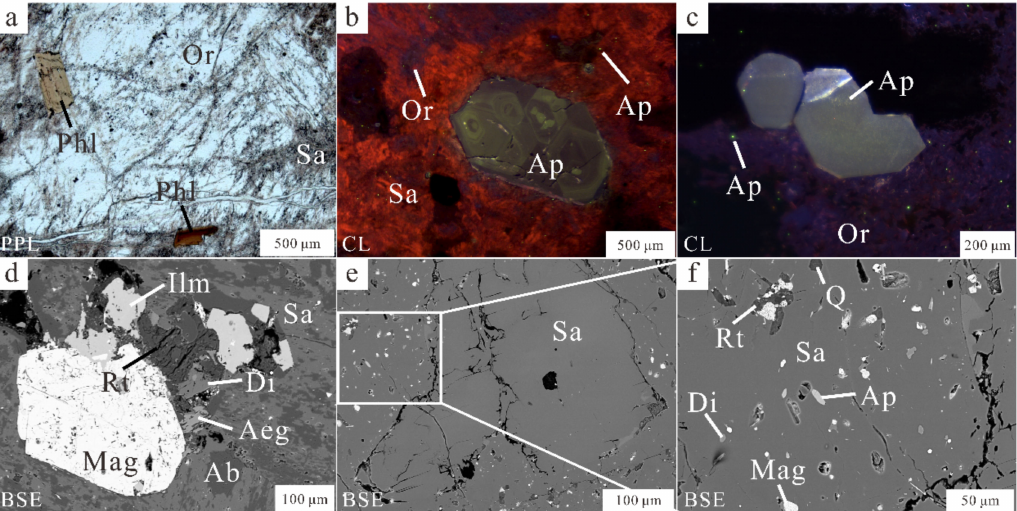
Figure 4. Transmitted plane-polarized light, cathodoluminescence, and back-scattered electron photomicrographs illus- trating the key petrographic features of syenite and apatite. ( a ) Coarse-grained orthoclase (Or), phlogopite (Phl), and sanidine (Sa) phenocryst in syenite; ( b ) prismatic magmatic apatite displaying oscillatory zoning with various levels of purple to yellow luminescence and sanidine showing a red CL color; ( c ) irregular apatite showing relatively uniform yellow luminescence; ( d ) minor phlogopite, apatite, quartz, magnetite, ilmenite (Ilm), rutile (Rt), aegirine (Aeg), and diopside (Di) in the groundmass; ( e , f ) tiny acicular apatite disseminated in quartz, magnetite, ilmenite, rutile, and